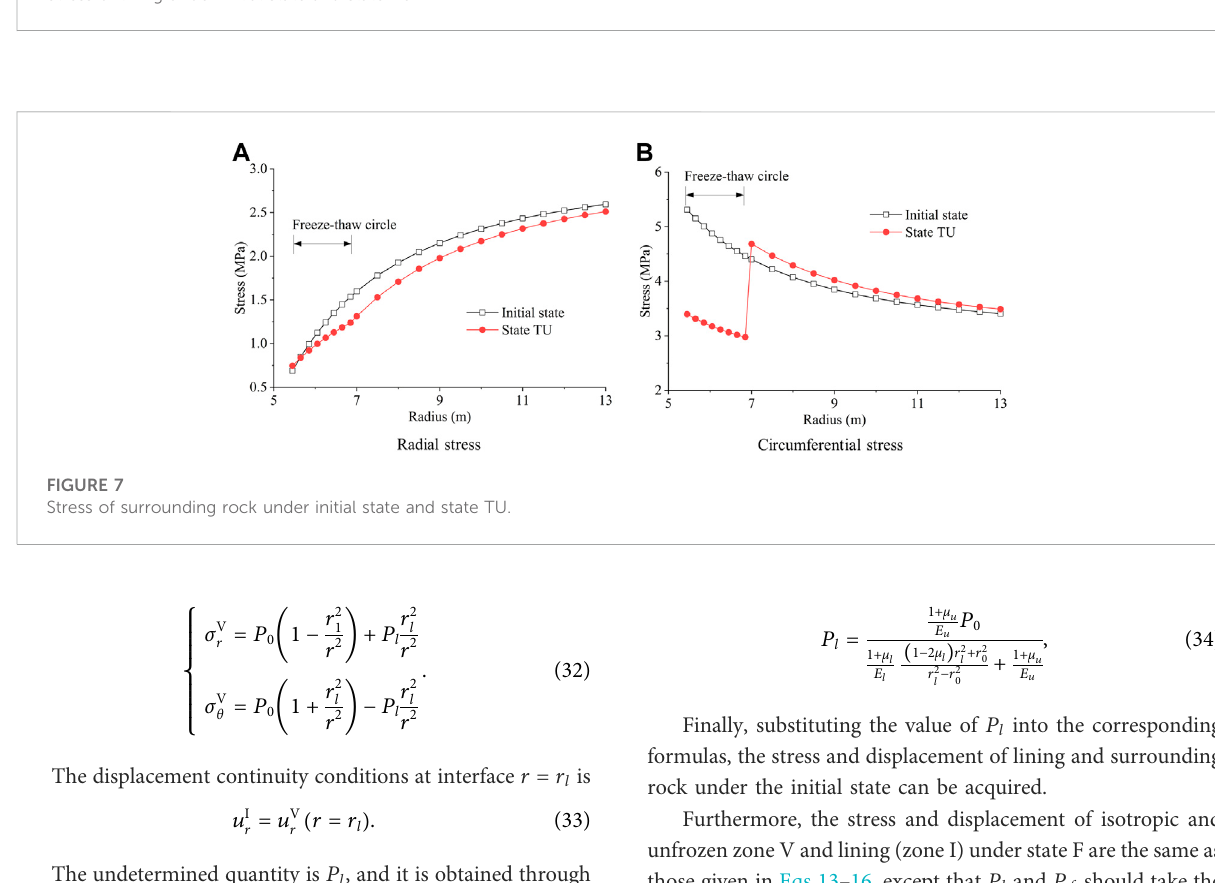
FIGURE 6 Stress of lining under initial state and state TU.